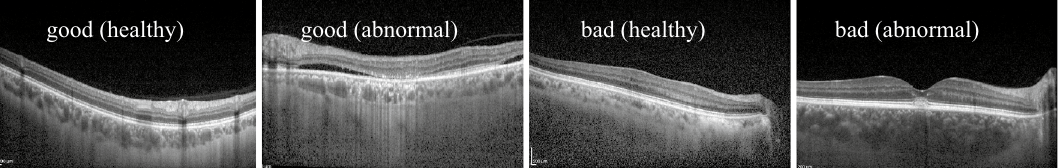
Figure 4. Representative OCT images annotated based on choroid quality by expert.